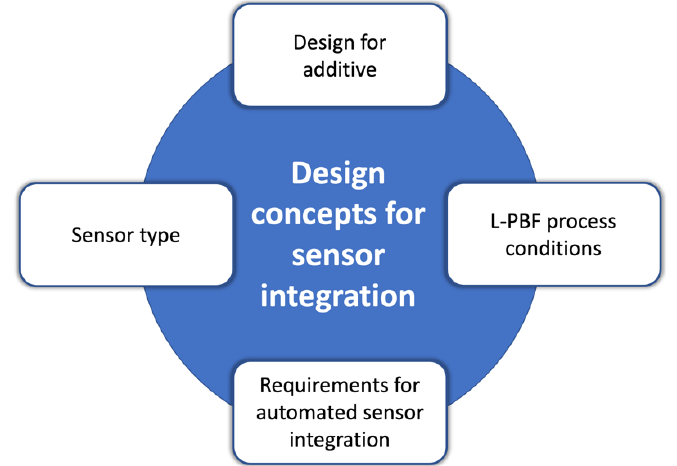
Figure 2. Influences on design concepts for sensor integration into metal L-PBF parts. Adapted from Reference [11], Binder et al. Procedia CIRP 2019 , 81 , 992 – 997,